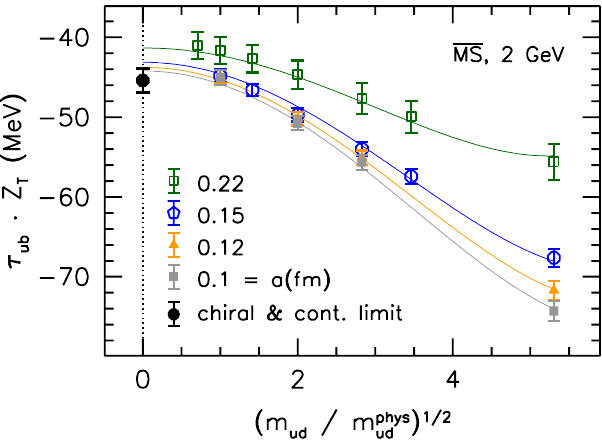
Figure 6 . Light quark mass-dependence of the tensor coe(cid:14)cient at T = 0 for the up quark using our four (cid:12)nest lattice spacings (green to gray symbols). The index b indicates that the QED divergence that one encounters at m ud > 0 has not been subtracted. The results diverge logarithmically towards the continuum limit for any m ud 6 = 0. In contrast, the chiral limit is free of ultraviolet divergences and a combined chiral and continuum limit exists (black